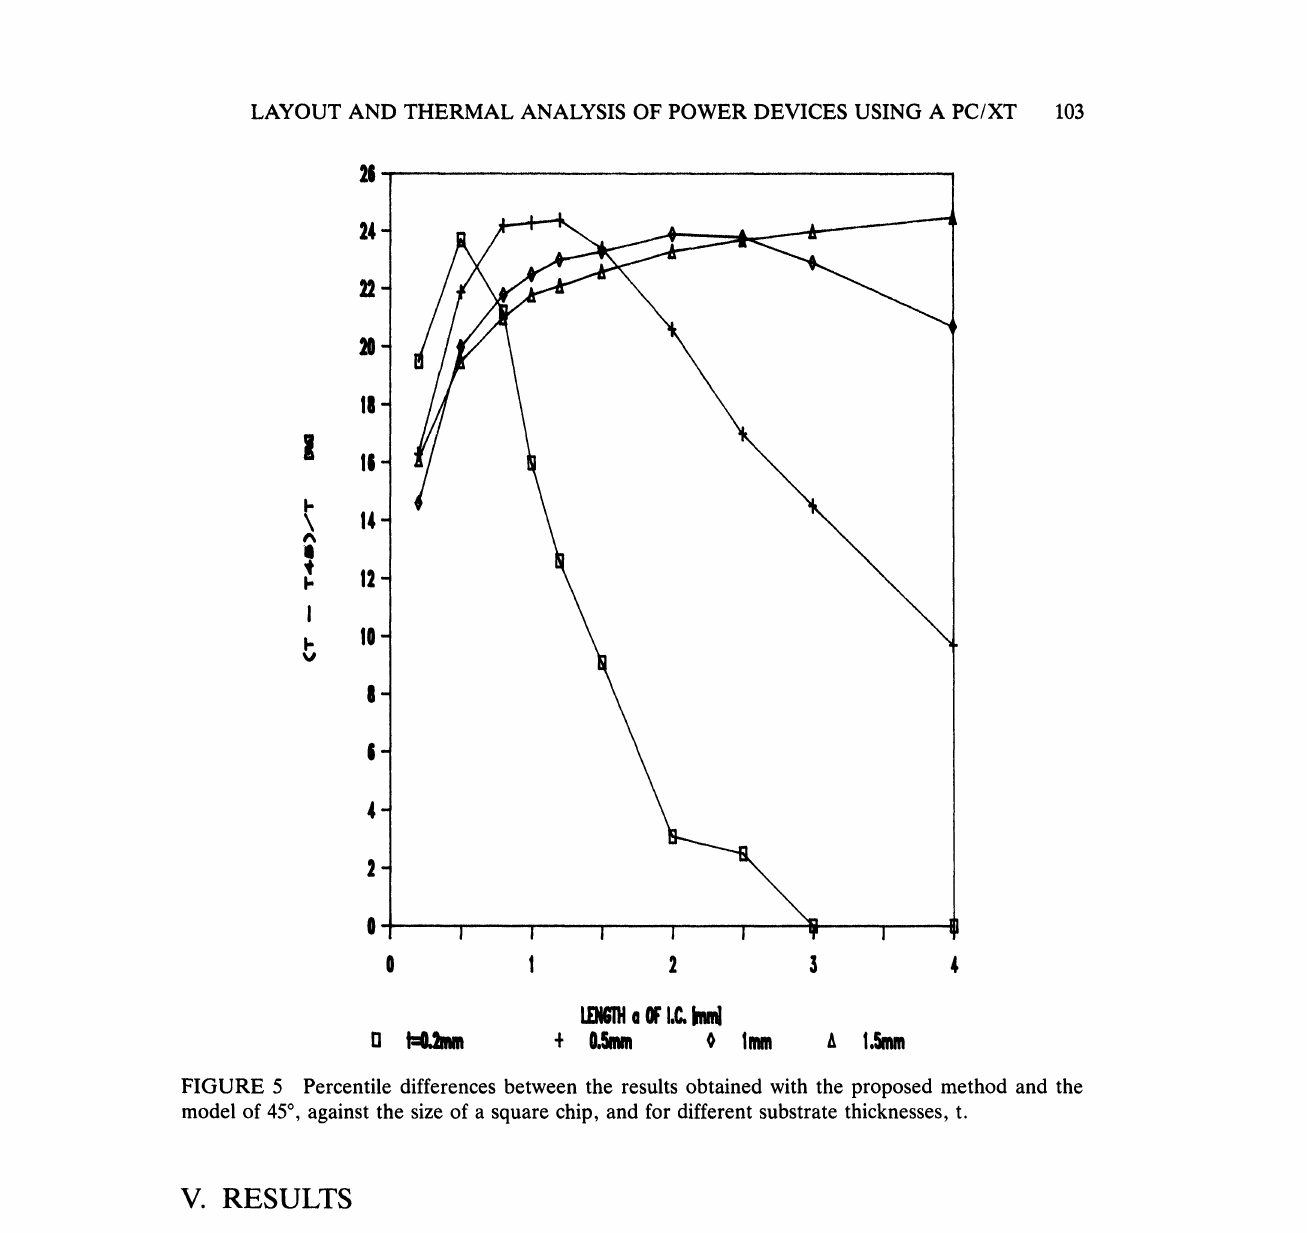
, FIGURE 5 Percentile differences between the results obtained with the proposed method and the model of 45 against the size of a square chip, and for different substrate thicknesses,